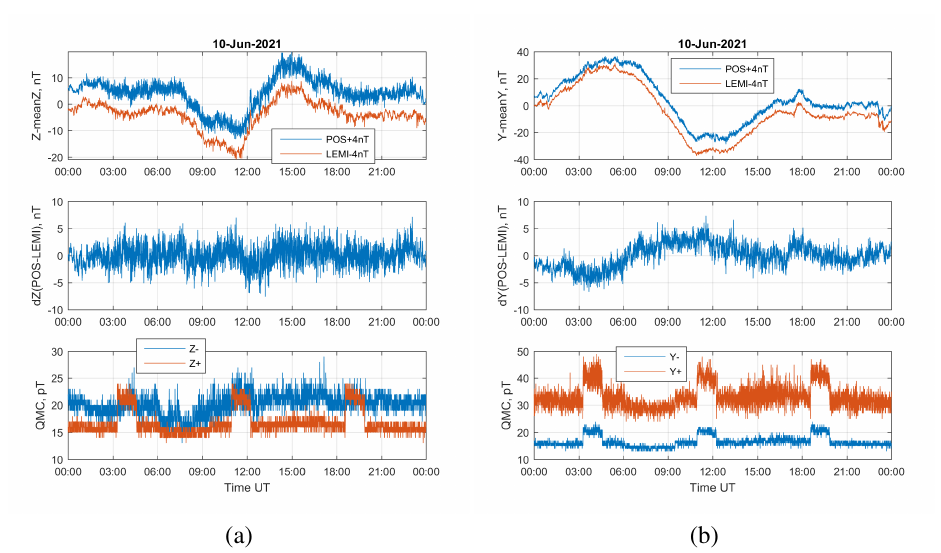
Figure 12. Example of measurements by POS-4 for 10.06.2021, components Z (a) and Y (b), a full measurement cycle of 15 seconds. For comparison, the raw 1-second data obtained at the Observatory Mikhnevo using the variometer LEMI-018 is presented.